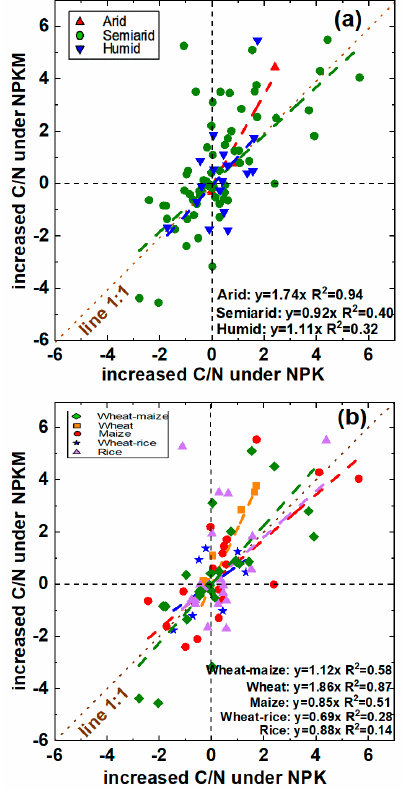
Figure 8. The linear relationships (y = ax) between the responses of increased soil C/N ratios (SOC/TN) to NPK and NPKM depending on the HI (humidity index) (HI = MAP/(MAT + 10)) ( a ) and crop type (wheat − maize, wheat, maize, wheat − rice, rice) ( b ). The horizontal dotted line indicates y = 0 and the vertical dotted line indicates x = 0. The thin lines indicate 1:1 ratios and dashed lines reflect the linear regressions. All regression lines are significant at p < 0.05. SOC: soil organic carbon. TN: total nitrogen. HI ≤ 25: arid region. 25 < HI < 50: semiarid region. HI ≥ 50: humid region. MAT: mean annual temperature, MAP: mean annual precipitation.